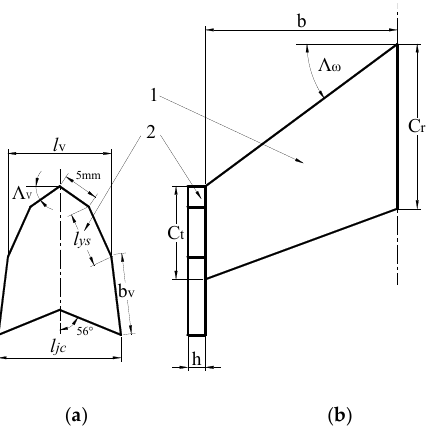
Figure 2. Structural parameters affecting endurance time. ( a ) Winglet structural parameters; ( b ) top view of the UAV. (1) wing; (2) winglet.